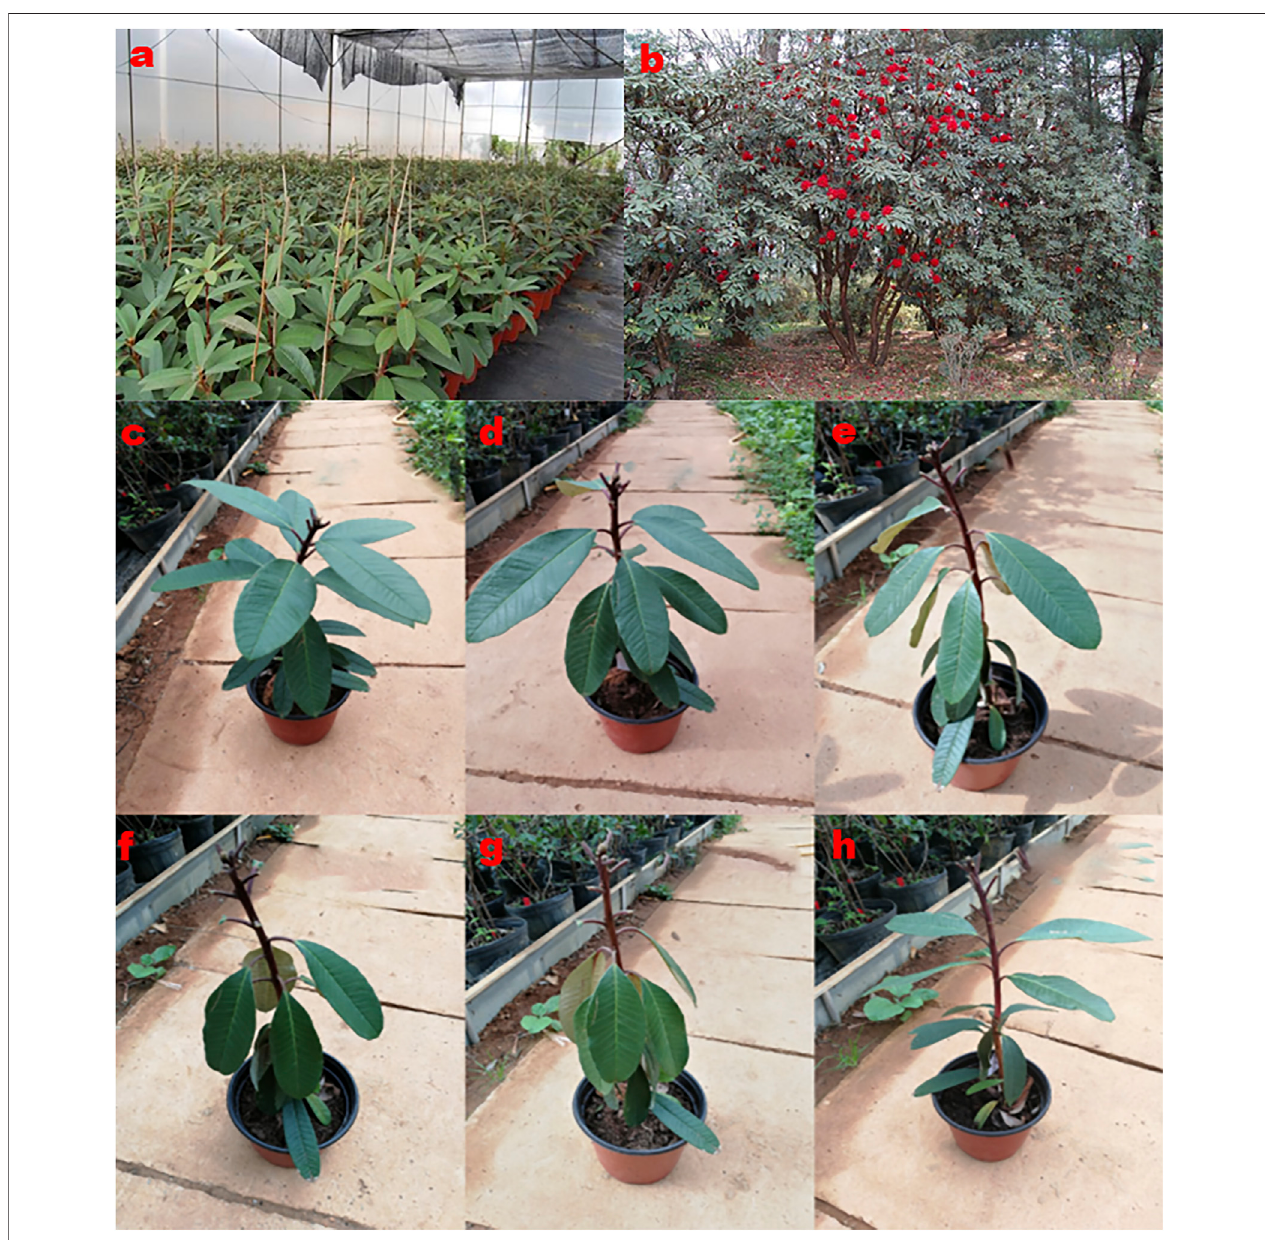
FIGURE 1 | Samples of R. delavayi plants used in this study. (A) Three-year-old potted, healthy young plants of R. delavayi that had not reached the reproductive growth stage. (B) Adult plants of R. delavayi were used in this study in the Kunming Jindian Scenic Area. (C-G) . Young plants under 9, 10, 11, 12, and 13 days drought stress, respectively, with severe leaf wilting at 11th, 12 th , and 13th day of stress. (H) Fully recovered plants after rewatering from 13 days of drought